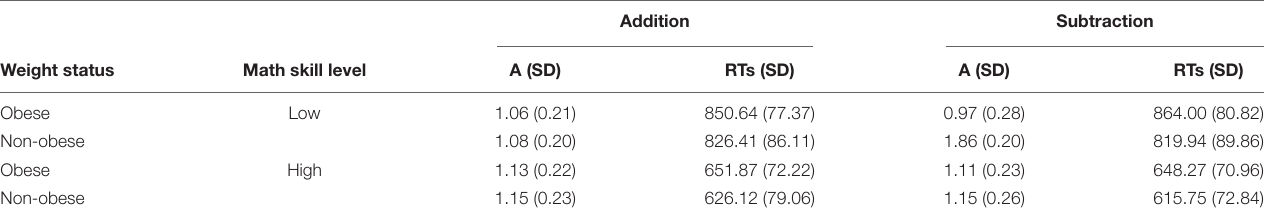
TABLE 3 | Behavioral results of math task